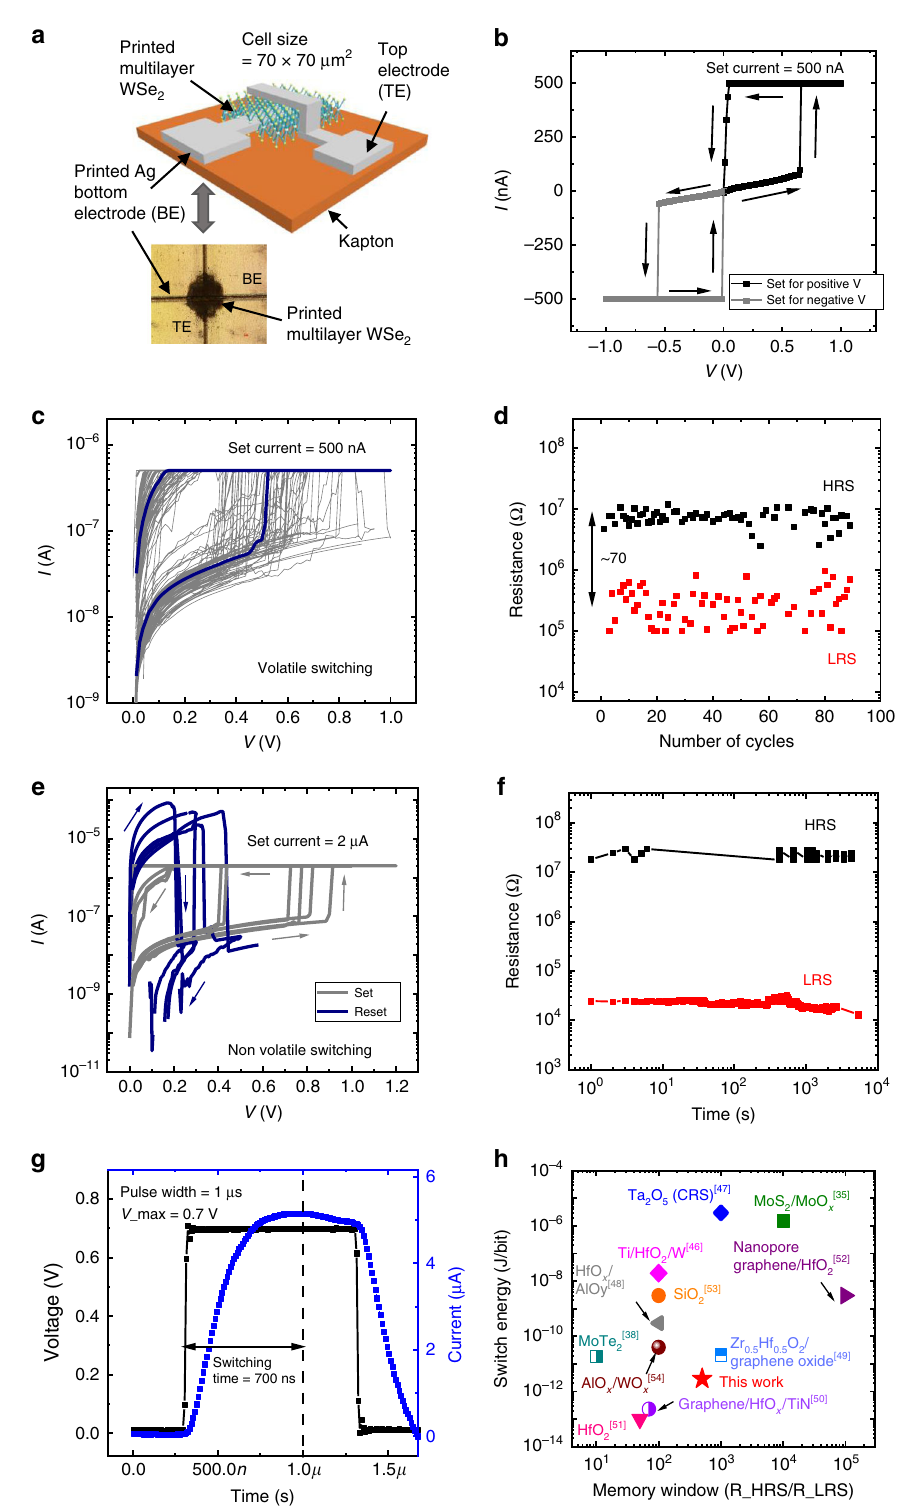
Fig. 3 Printed WSe 2 ReRAM electrical characterization. a Schematic of printed WSe 2 ReRAM with Ag contacts along with microscope image of printed ReRAM. b The device sets from HRS to LRS for both positive and negative voltages. c Stress cycling data for 90 cycles at a smaller set current of 500 nA, where volatile behavior is observed. d Endurance properties of ReRAM at read voltage of 50 mV and a set current of 500 nA. e Set and reset operation with a larger set current of 2 µ A, exhibiting non-volatile behavior. f Retention plot showing LRS and HRS stability till 10 4 s at a read voltage of 50 mV and set current of 5 µ A. g Switching time characterization with an AC pulse of 0.7 V amplitude and 1 µ s pulse width. h Benchmark plot of switching energy per bit vs. memory window of printed WSe 2 ReRAM with other representative non-volatile resistive switching